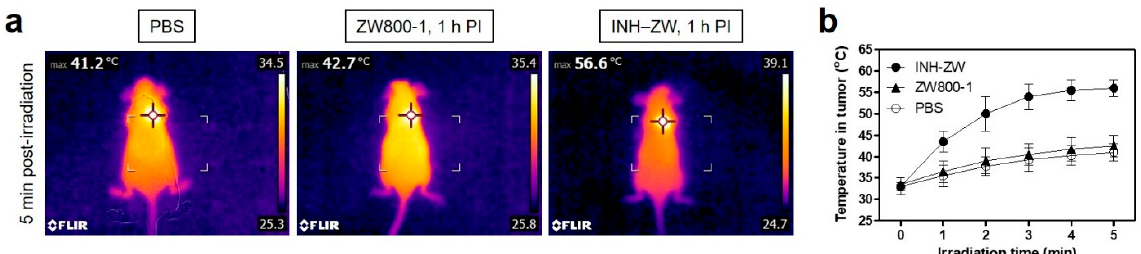
Figure 6. ( a ) Whole-body thermal images of tumor-bearing mice 1 h after injection of PBS, ZW800-1, or INH–ZW upon exposure to 808 nm laser irradiation (1.1 W/cm 2 ) for 5 min. ( b ) Temperature changes at the tumor sites in each treatment group were monitored during the 5 min of 808 nm laser irradiation. Data are expressed as the mean ± S.D. of three independent experiments.